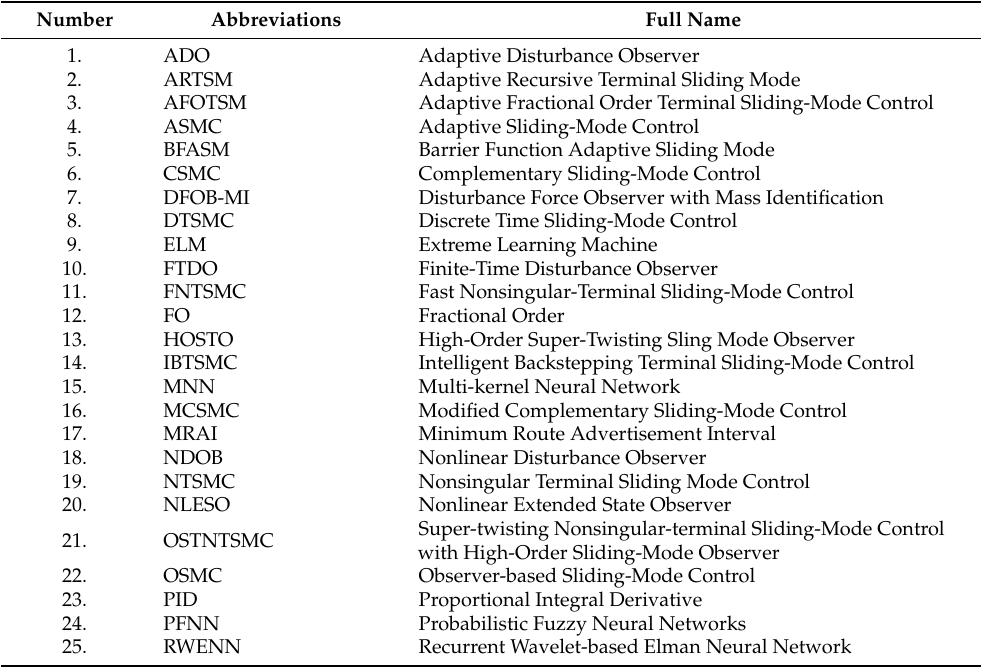
Table 1. Abbreviations and full